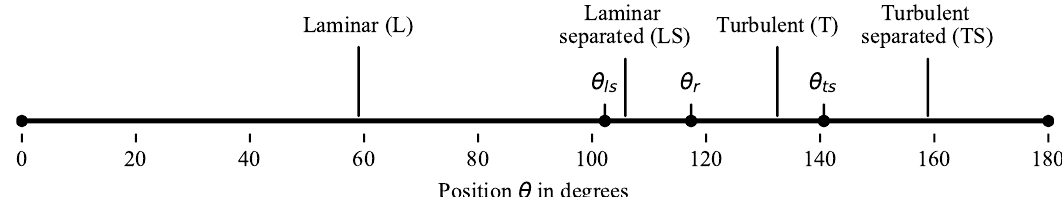
Figure 3. Oil paint measurement on a 160mm diameter cylinder in cross-flow at a Reynolds number of Re = 5.1 × 10 5 . The beginning and end of the different boundary layer flow regimes is visible by the accumulation of